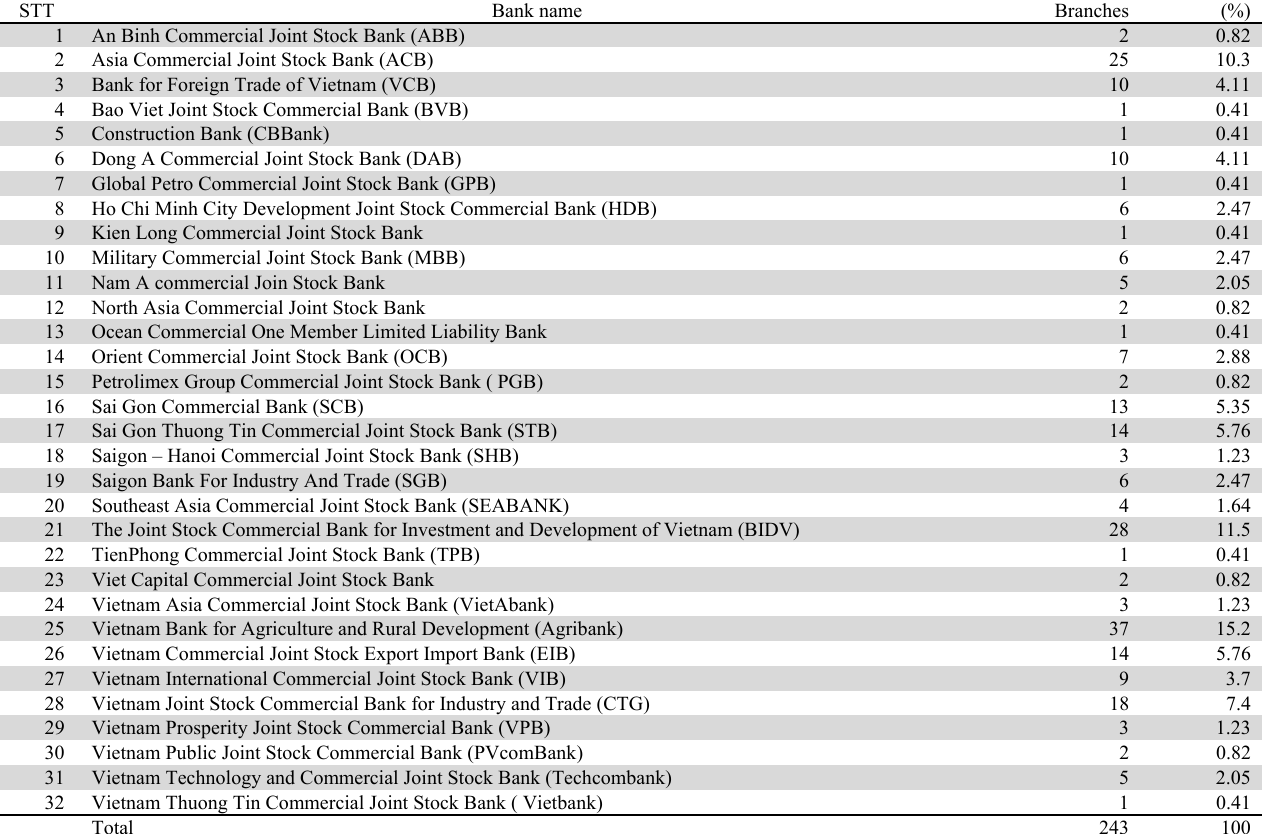
Survey sample statistics at bank branches in